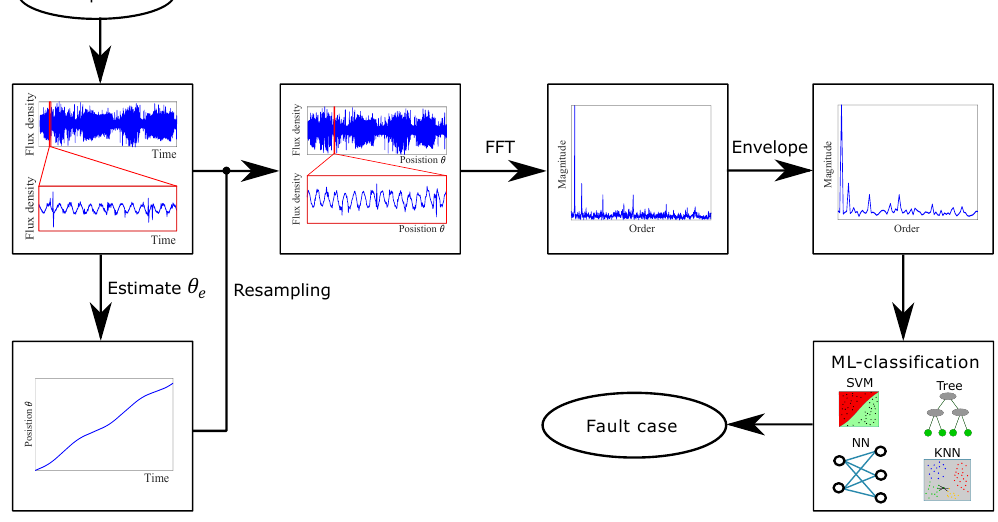
Figure 1. Block diagram of preparation of